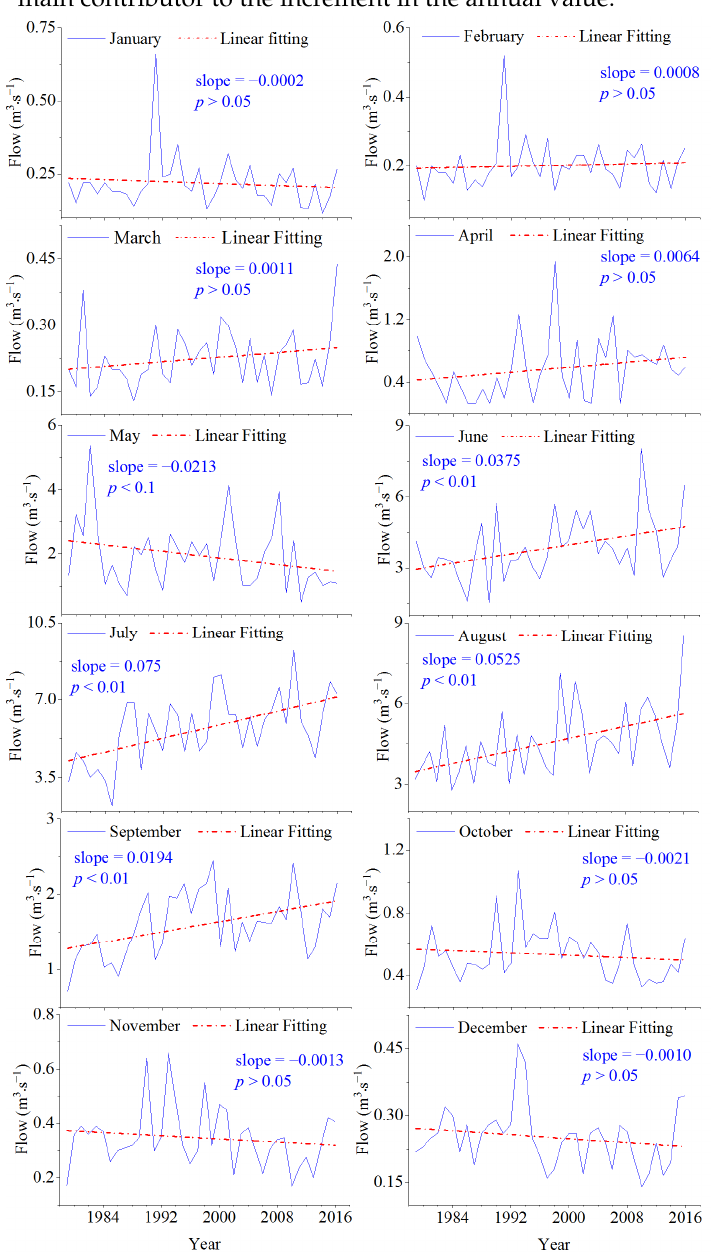
Figure 6. Variation of the monthly flow in the Yushugou Basin from 1979 to 2016.